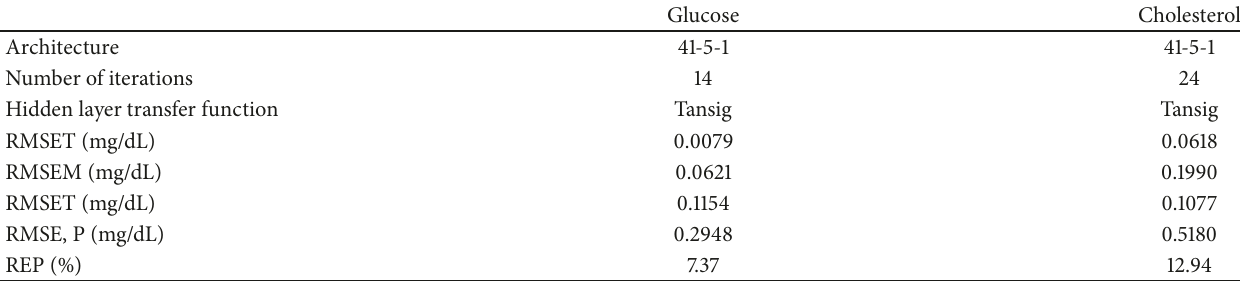
Table 4: Parameters and errors obtained with data set (smoothing 5 pts) by ANNs model.